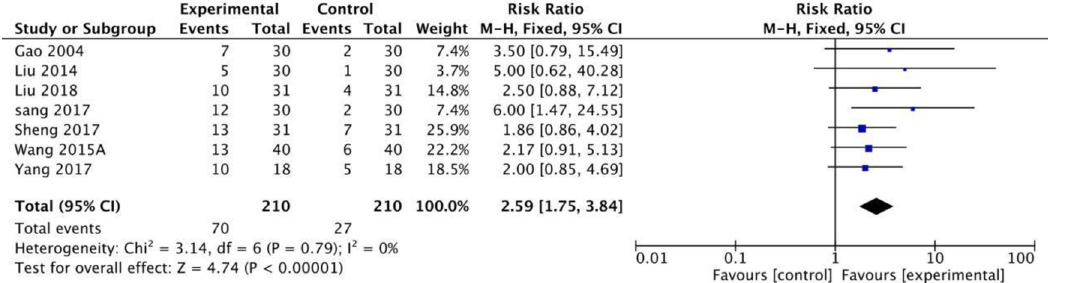
Fig 4. Meta-analysis of fire acupunture versus acupuncture for spasticity after stroke in RR.